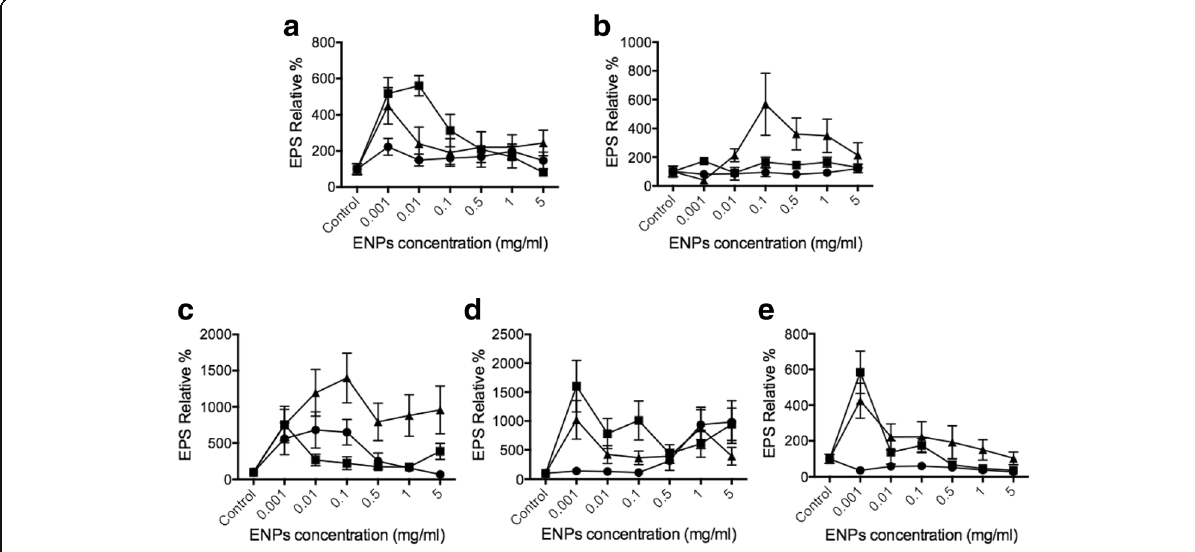
Fig. 3 EPS release triggered by various ENPs. Different phytoplankton cells a Dunaliella tertiolecta , b Thalassiosira pseudonana , c Skeletonema grathae , d Phaeodactylum tricornutum , and e Odontella mobiliensis were treated with TiO 2 (circles), SiO 2 (triangles), CeO 2 (squares), respectively, with concentrations of 5 mg/ml and 1 mg/ml, 0.5 mg/ml, 0.1 mg/ml, 10 μ g/ml, 1 μ g/ml ( n =